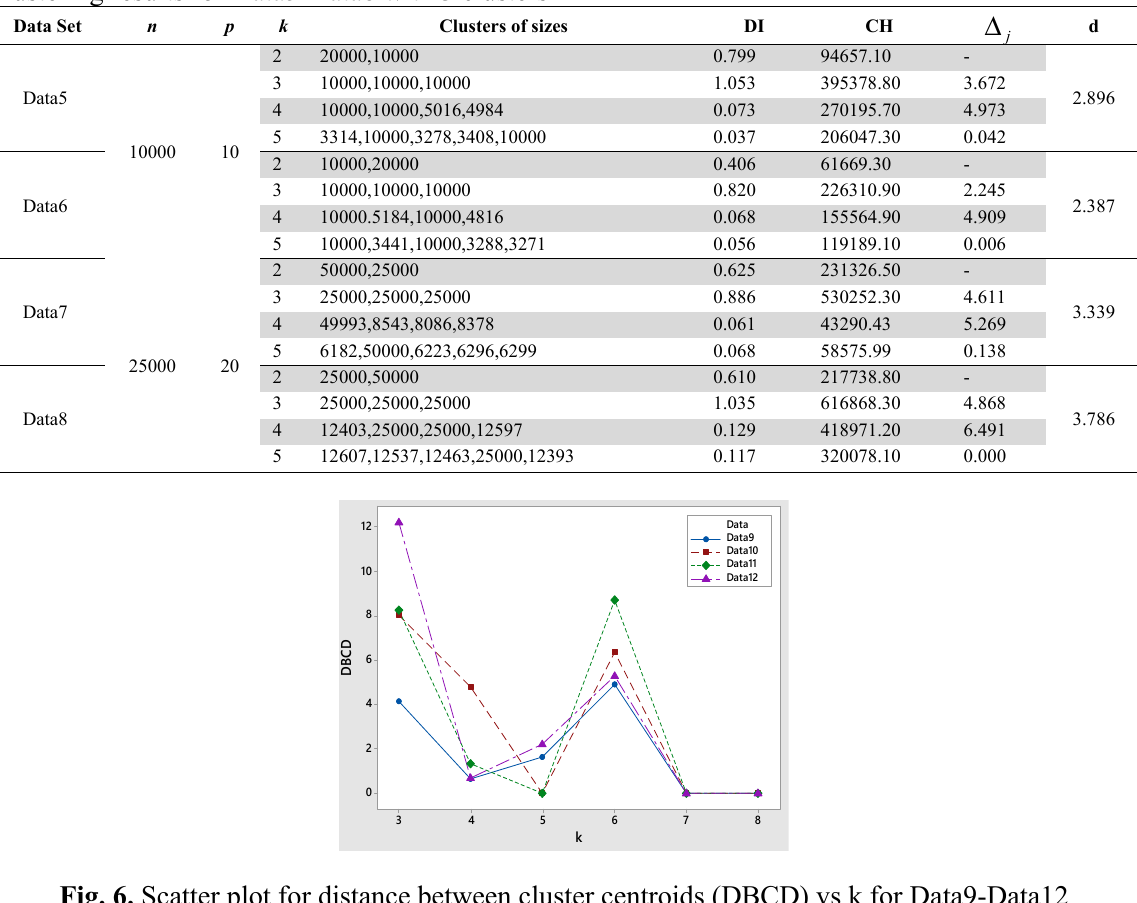
Clustering results for Data5-Data8 with 3 clusters